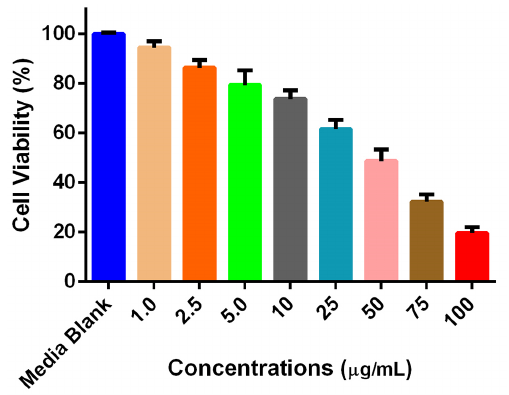
FIGURE 8 - MTT assay of lenalidomide - PLGA-NPs.